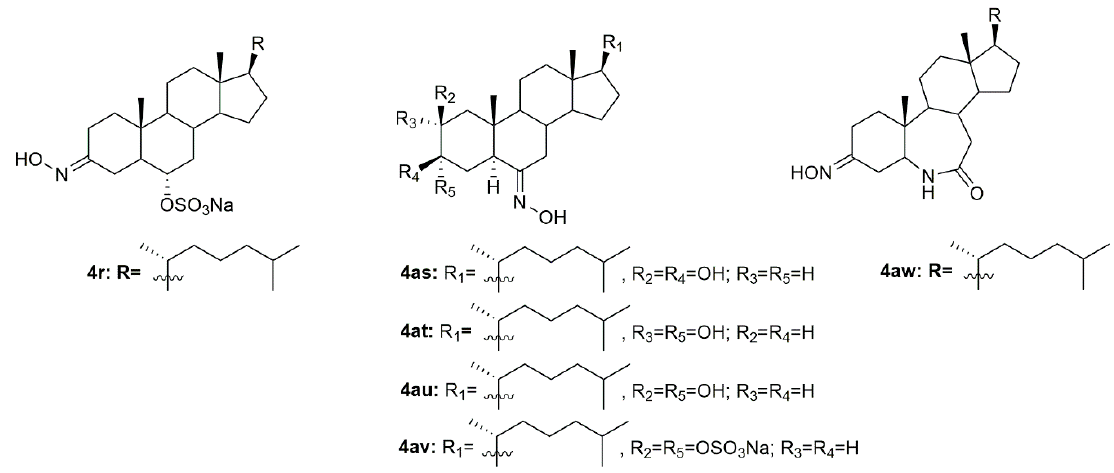
Figure 7. Steroidal cholestane oxime derivatives with antitumor activity in several types of cancer cells. Table 4. IC 50 values (µM) of the synthesized cholestane oxime derivatives.